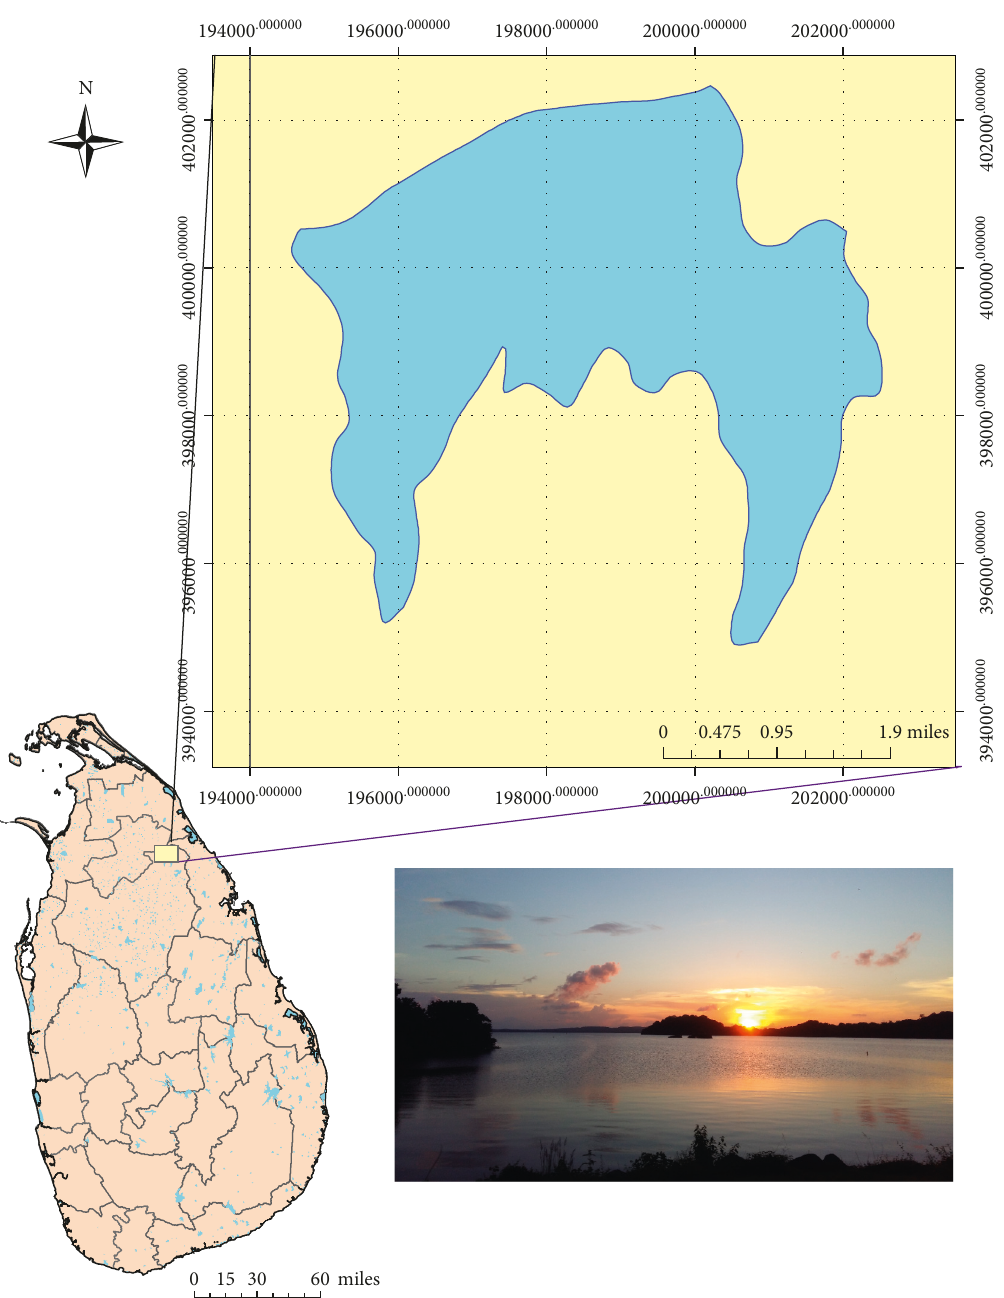
Figure 1: Padaviya